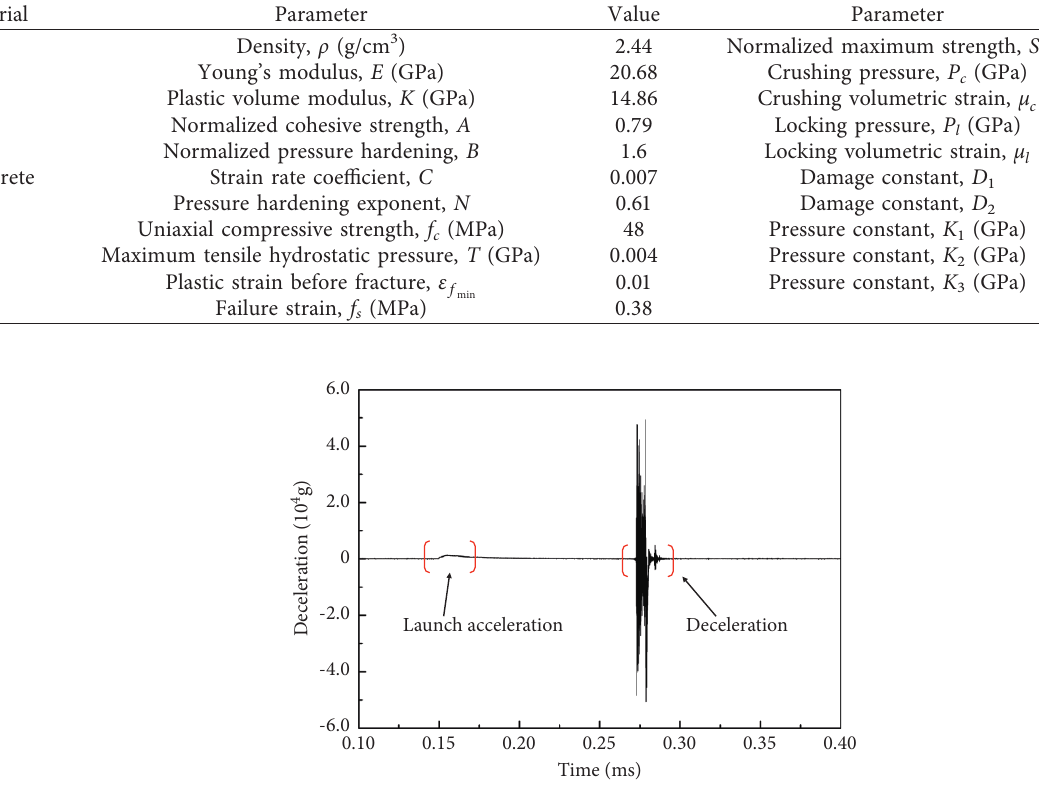
Figure 9: Deceleration-time curve of the prototype